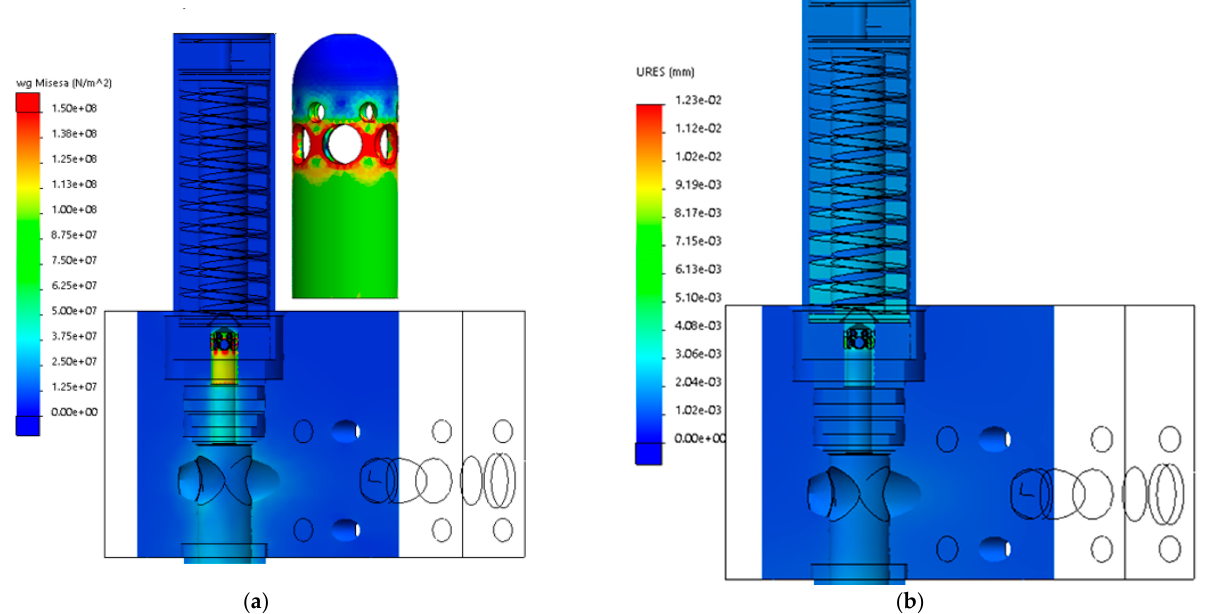
Figure 23. The variation map of von Misses stress ( σ ) ( a ) and displacement ( d) ( b ) for a 0.007 m 3 ·s -1 volume flow rate (420 L·min -1 ).